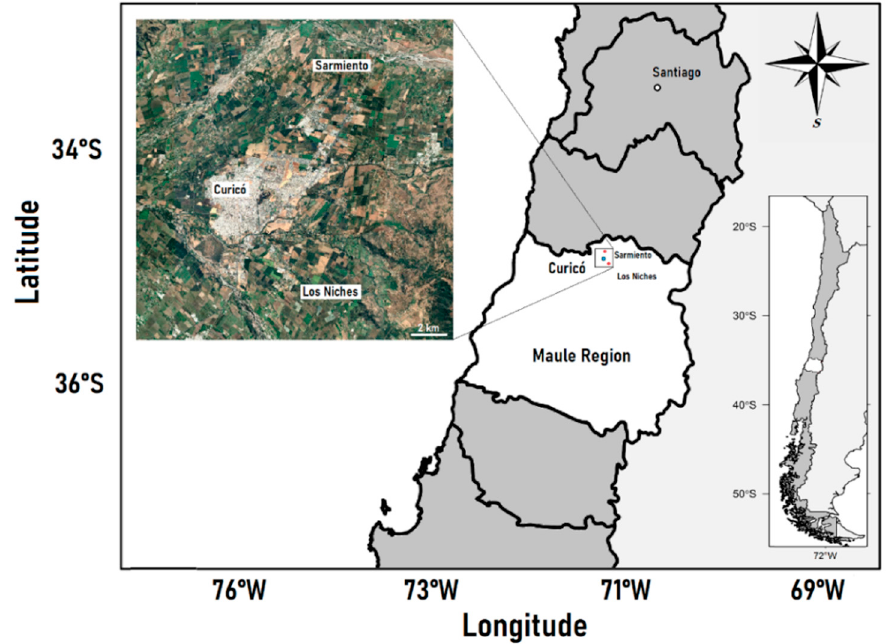
Figure 1. Location of the sampling sites of the study. The main map shows the study site (black square) within Chile and the Maule Region. The inset picture shows the specific sampling points of exposed (Sarmiento and Los Niches) and unexposed (Curicó) groups.